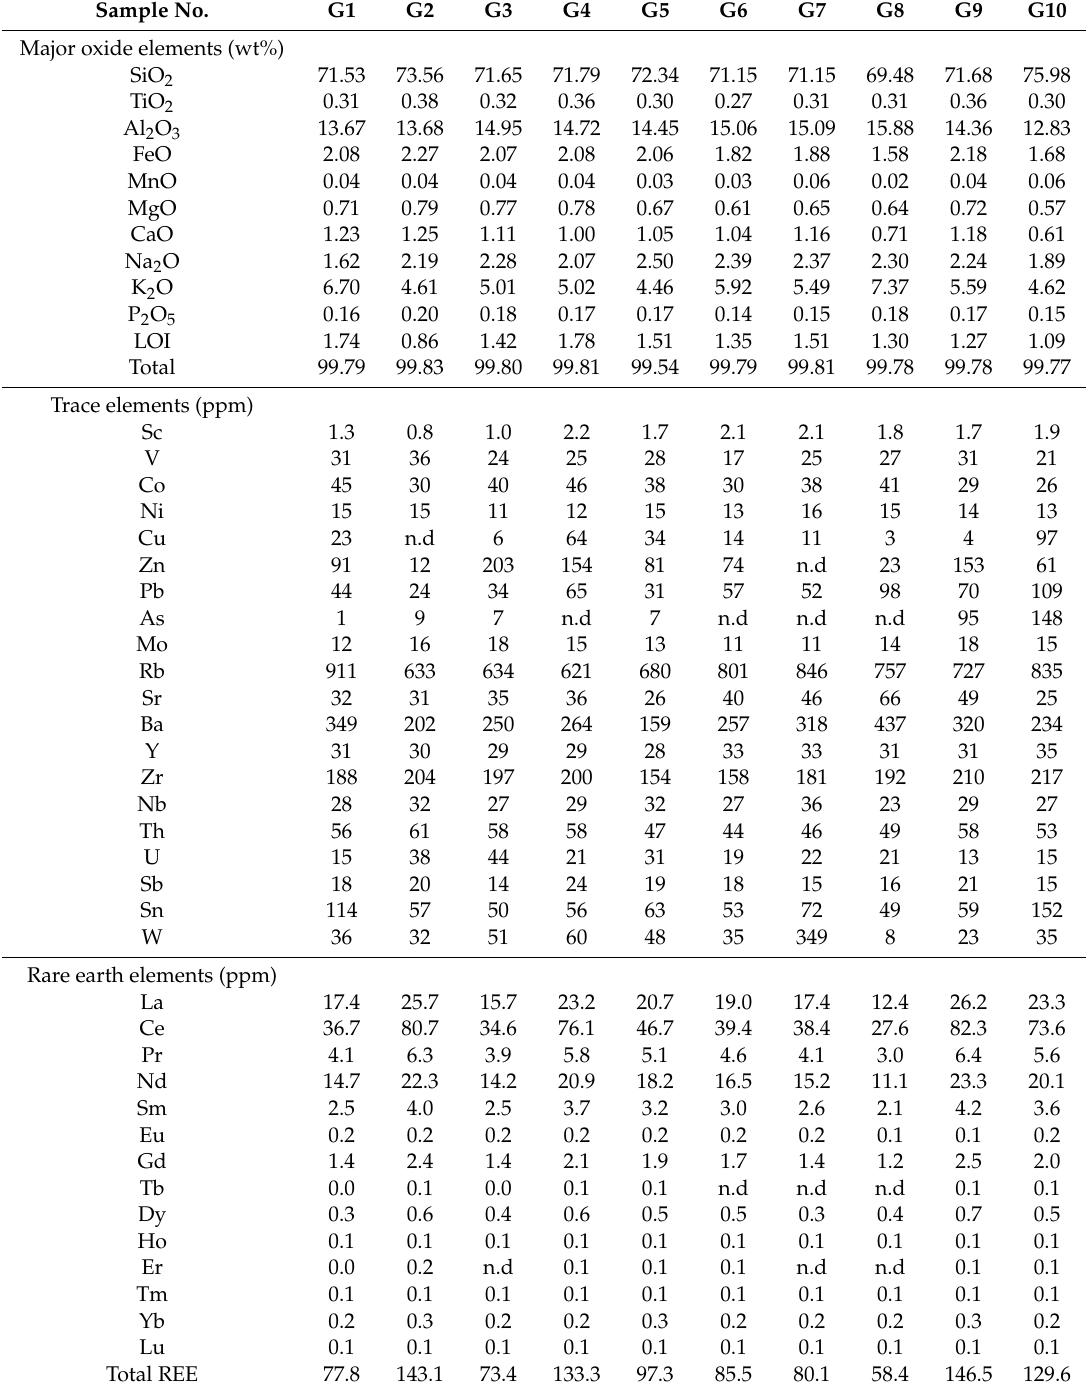
Table 1. Results of major (in wt.%) trace elements, including rare earth elements (in ppm) data for the Tagu granite samples, Southern